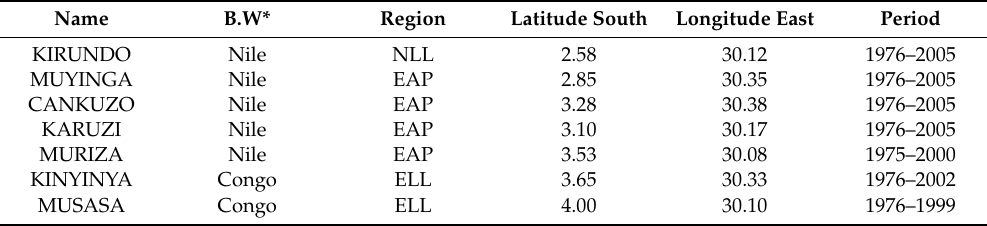
Table 1. Geographic characteristics of meteorological stations